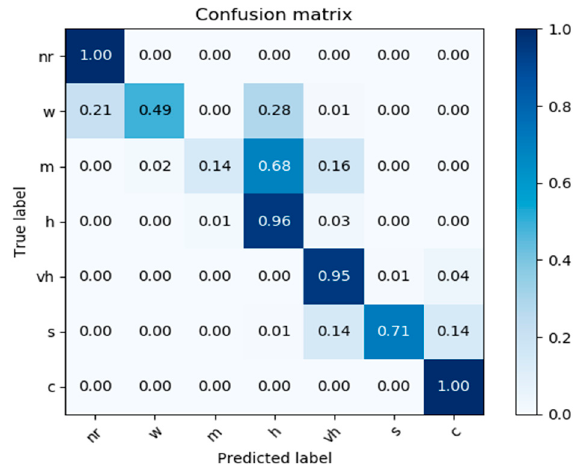
Figure 13. Confusion matrix.